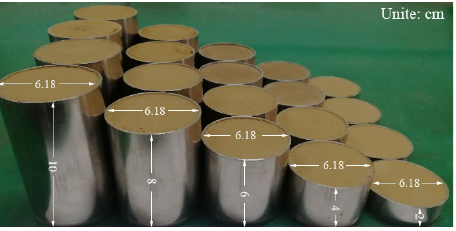
Figure 2. Remolded loess samples with different H/D ratios.